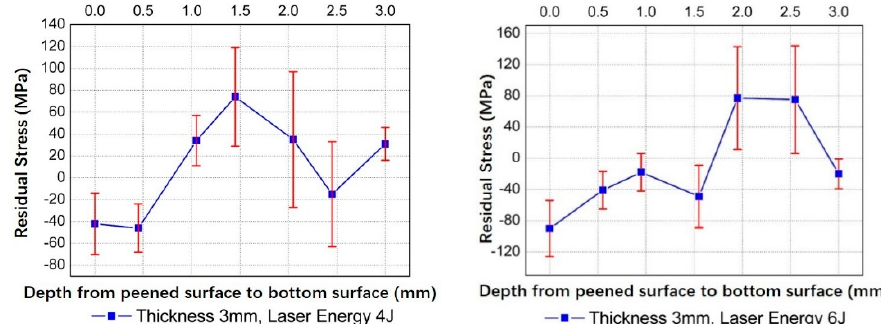
Figure 8. Stresses measured along the depth of 3 mm target for laser energies of 4 J and 6 J.